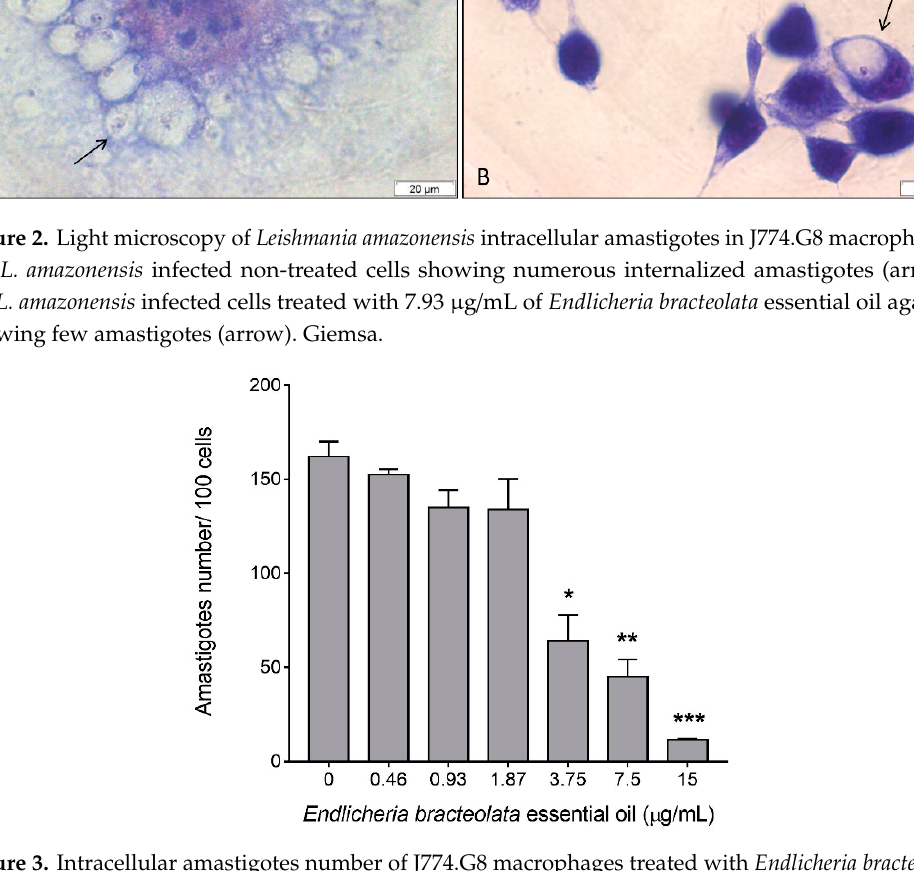
Figure 3. Intracellular amastigotes number of J774.G8 macrophages treated with Endlicheria bracteolata essential oil for 24 h. Each column represents the mean number of intracellular amastigotes in cell cultures treated with di ff erent concentrations of E. bracteolata essential oil. The value represents the number of amastigotes counted in 100 cells in three independent experiments carried out in duplicate. * p < 0.05; ** p < 0.01; *** p < 0.001 when compared to untreated cells by Kruskal-Wallis and Dunn’s multiple comparisons test.